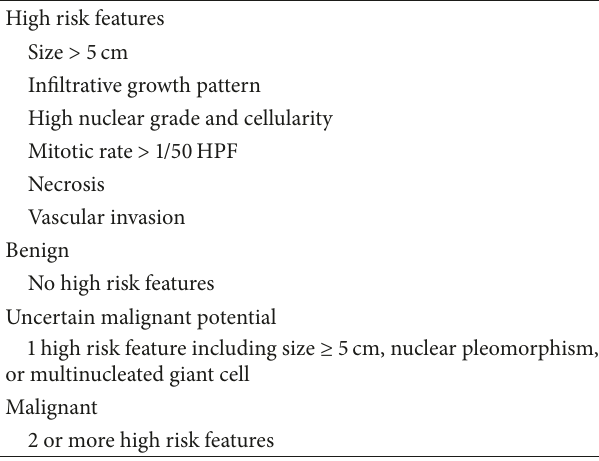
Table 1: Classification of PEComas (adapted from Bleeker and Folpe, [5,